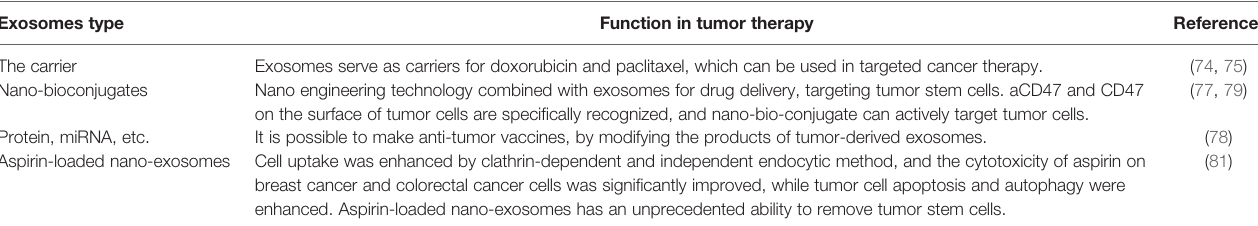
TABLE 2 | Exosomes and tumor